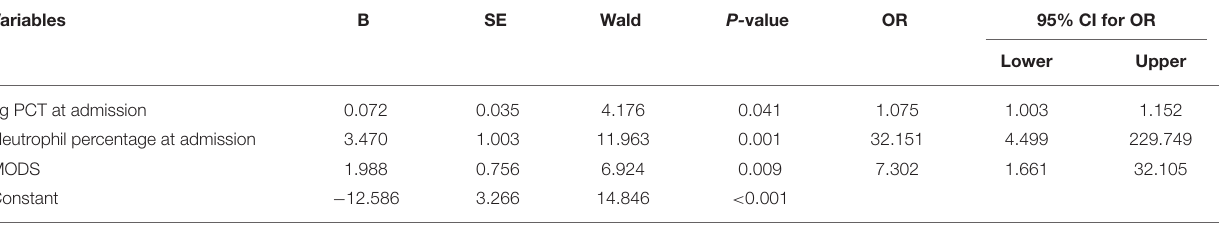
TABLE 7 | Independent risk factors associated with mortality in patients with HFRS.